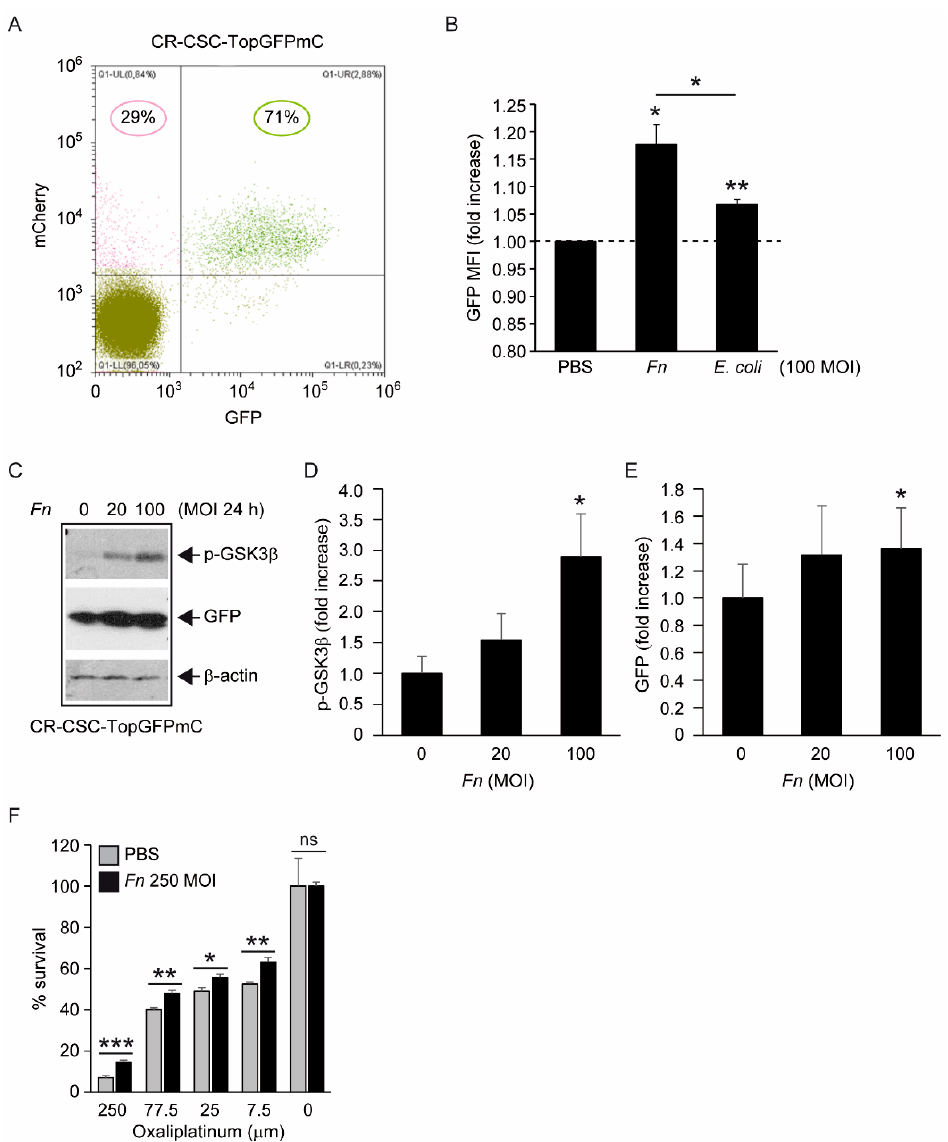
Figure 3. Constitutive Wnt activity in CSC-P cells and modulation by Fn. ( A ) Flow cytometry analysis of red/green fluorescence distribution in CSC-P cells transduced with the Wnt reporter TopGFPmC. Percentages in the upper quadrants refer to the mCherry+ population expressing the reporter. ( B ) Effect of bacterial infection on green fluorescence intensity within the GFP+/Red+ population (UR quarter). Fn, or E. coli were administered at 100 MOI for 48 h in a growth-factor-free medium. Values are the GFP mean fluorescence intensity (MFI) normalized to the untreated sample. Representative of two–three independent experiments; * p < 0.01 and ** p < 0.005 by a single-sample t -test (two-tailed). * between columns: p < 0.05, unpaired t -test. ( C ) Immunoblot detection of phospho(Ser 9) GSK3 β and GFP in lysates from reporter-transduced CSC-P under the indicated treatments. Arrows highlight relevant bands and equal loading. ( D , E ) band densitometry from multiple (n = 3–4) experiments as in ( C ). Values are the mean ± S.E.M of the band intensities normalized to the untreated sample’s mean ( Fn 0 MOI). * p < 0.05 vs. 0 MOI by ANOVA for correlated samples. ( F ) Cell-Glo ® luminescent survival test for the effect of heat-killed Fn (250 MOI) on CSC-P cell sensitivity to Oxaliplatin. Columns are the mean ± SD of triplicate samples, normalized to the mean of the untreated wells (100% survival). Raw values for the untreated samples in the PBS and Fn groups were 5.035.374 ± 676.612 and 4.732.458 ± 89.854 ( p = 0.48), respectively. Picture representative of two independent experiments. * p < 0.05; ** p < 0.01; *** p < 0.005, unpaired Student’s t -test on normalized values.